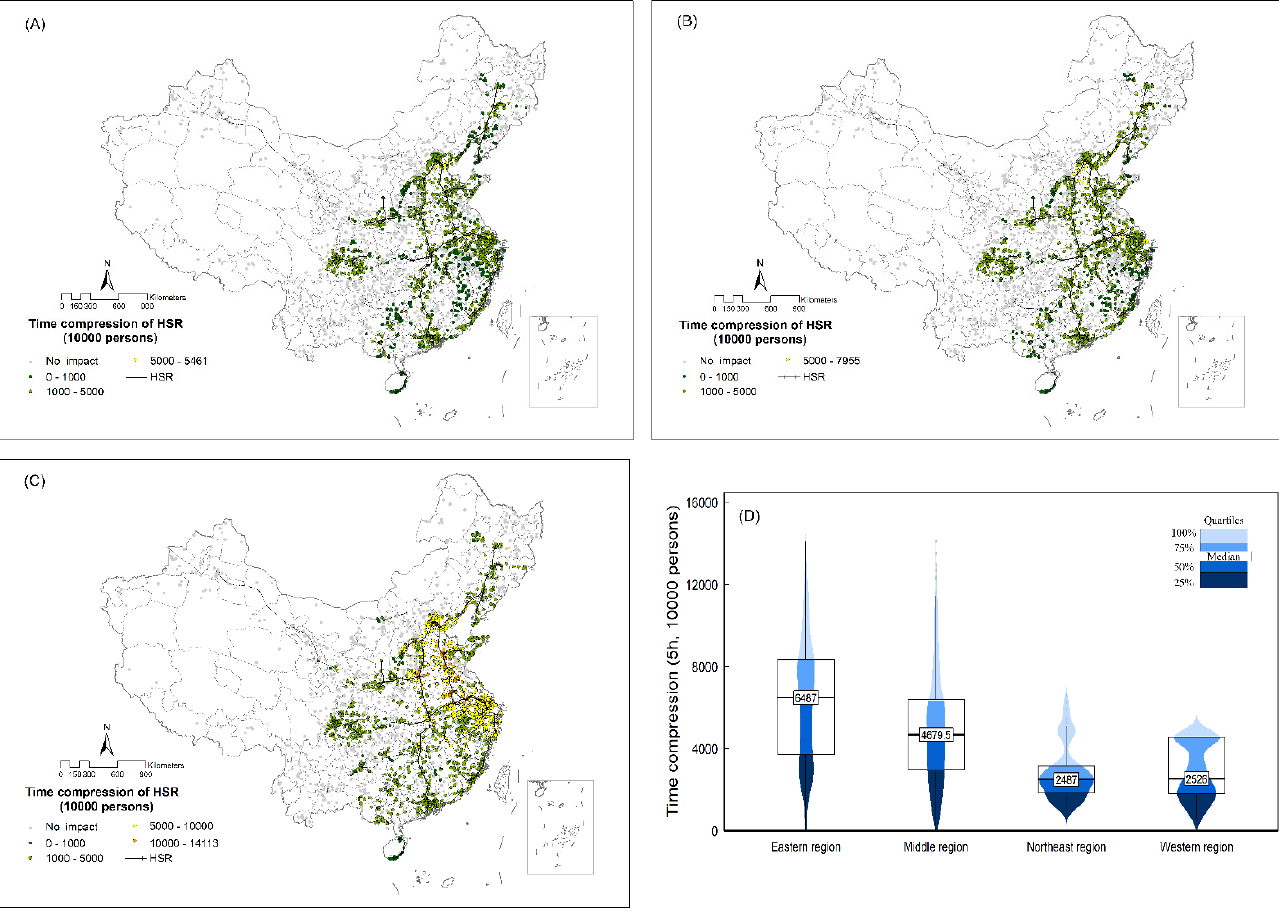
Figure 4. TC effect of HSR on tourist destinations. ( A – C ) represent the TC effect under temporal distance of 3 h, 4 h and 5 h respectively during 2008–2019. ( D ) shows the Violin Plot of TC effect of HSR in four regions of China (5 h).